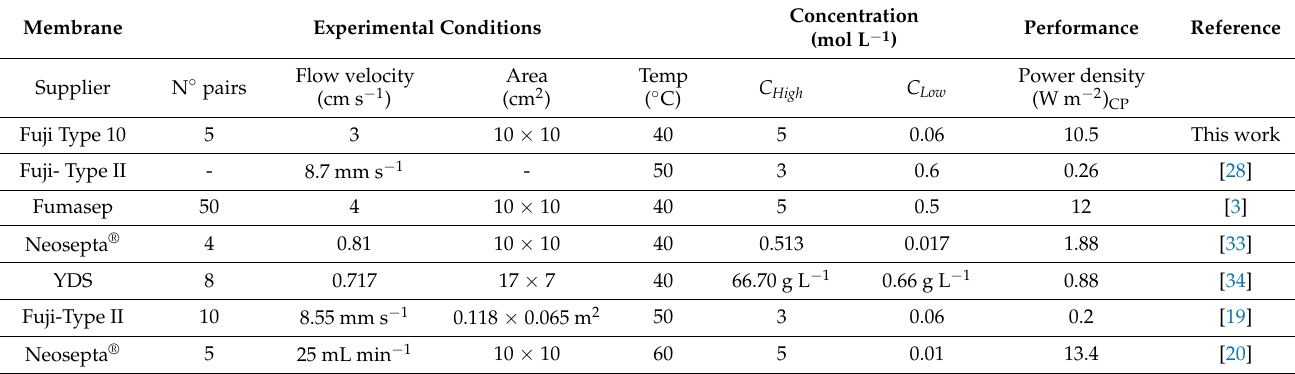
Table 4. Comparison of present data to those previously reported in the scientific